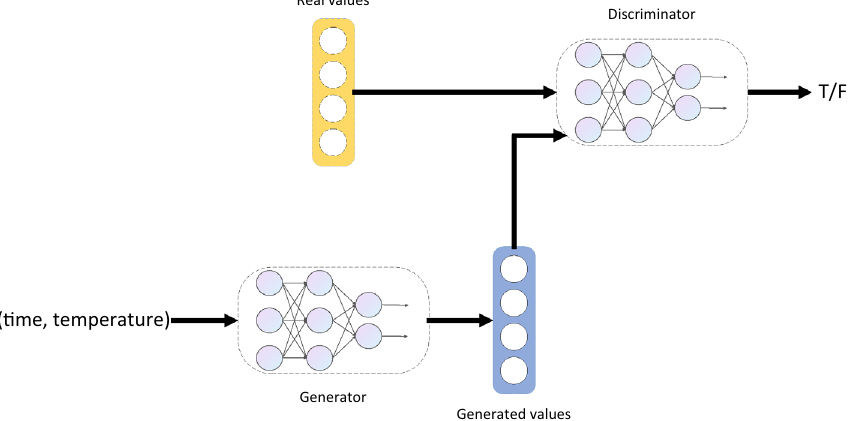
Figure 1. The framework of our proposed